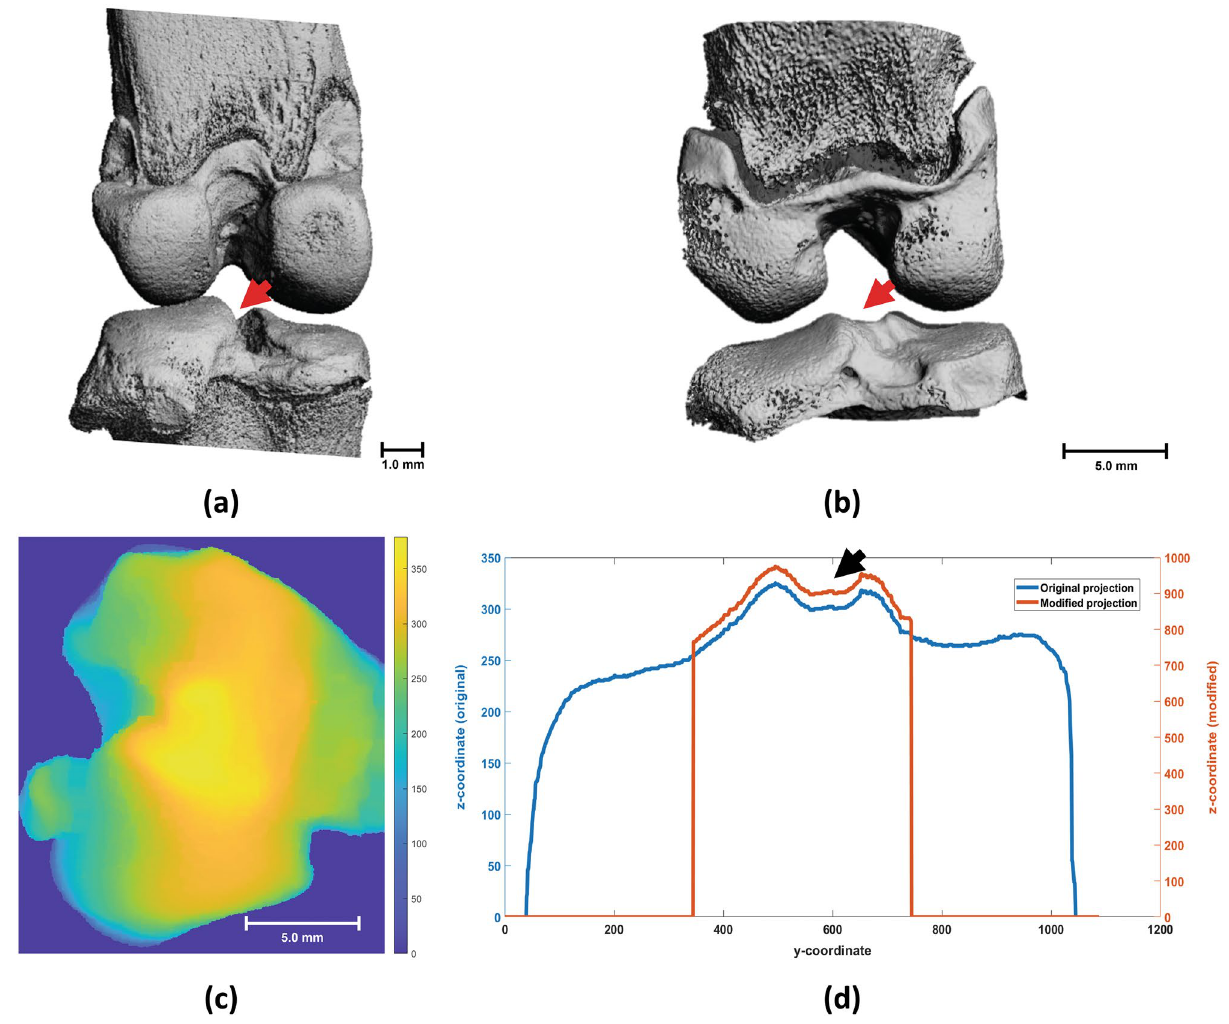
Figure 3. ( a ) Rat and ( b ) rabbit tibial intercondylar eminence used as the dividing point (red arrows) of the subdivision module. ( c ) Topographic map of the projections from a rabbit tibial plateau with values representing z-coordinates. ( d ) Subsequent 1D projection demonstrating the height profile of the tibia (blue line) as well as the cropped and boosted profile (orange line) used in actual computation of the point (black